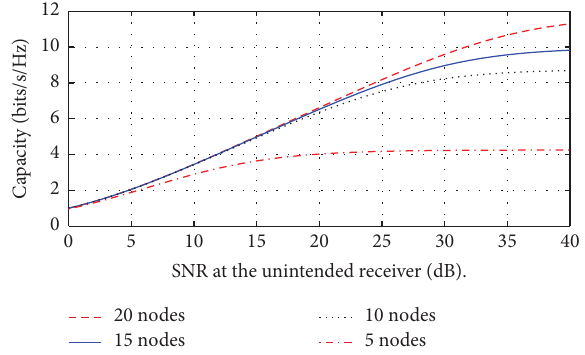
Figure 16: Capacity comparison: unintended receiver at (140 degrees azimuth, 60 degrees